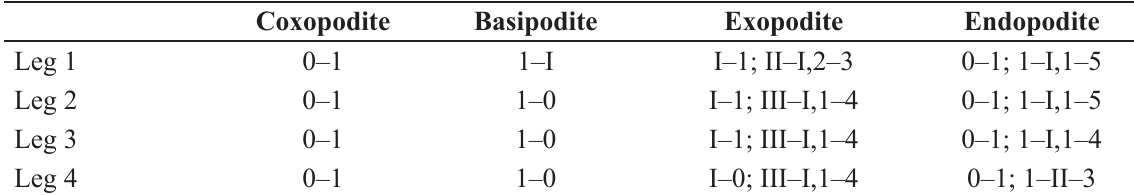
Table 3. armature of legs 1−4 in civ instar of Cyclops bohater koźmiński, 1933 (coding system as in table